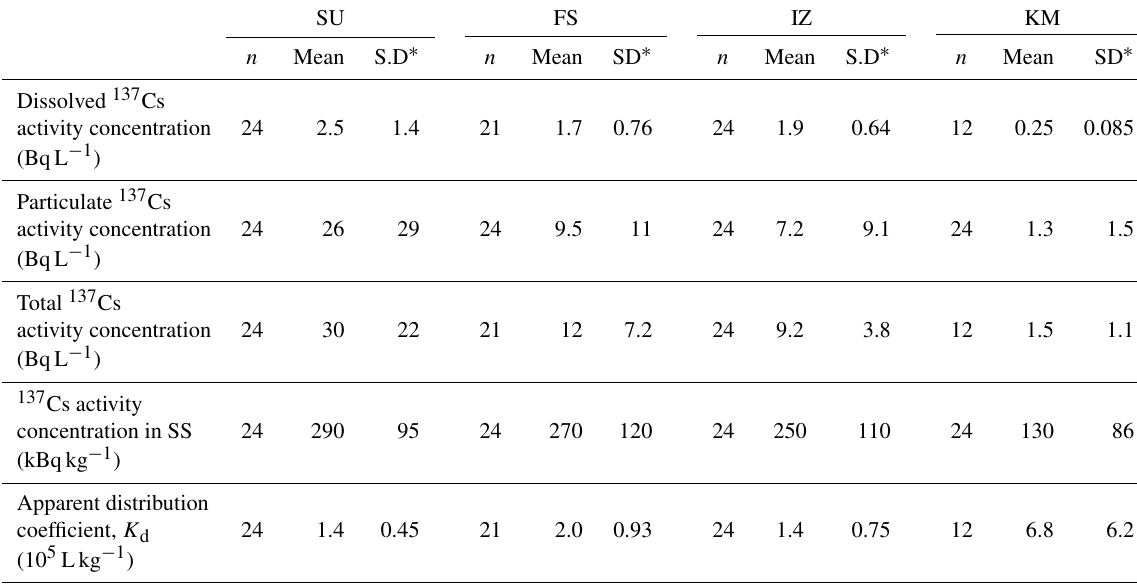
Table 1. Summary of 137 Cs activity concentration in pond